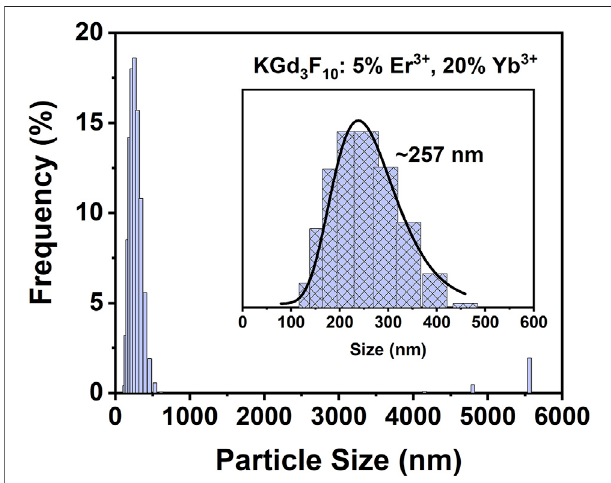
FIGURE 4 | Hydrodynamic diameter distribution of the 5% Er 3+ , 20% Yb 3+ : KGd 3 F 10 NPs dispersed in DMEM medium with 10% FBS obtained by DLS technique.